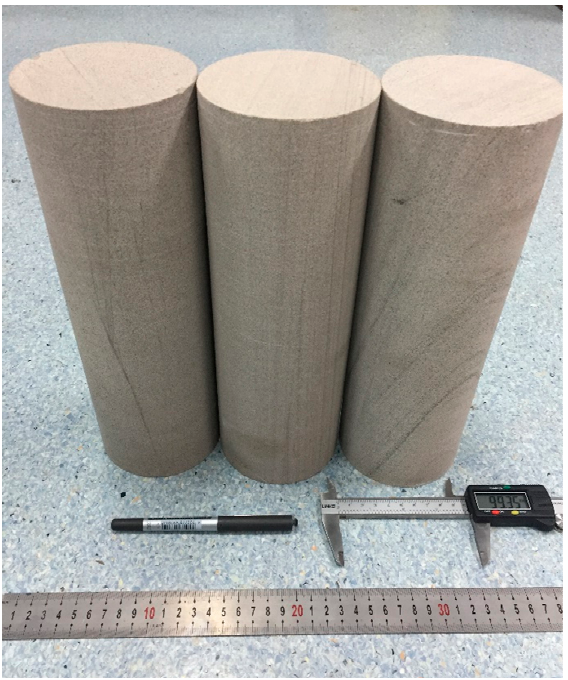
Figure 1 . Core samples used in the experiment. Figure 1. Core samples used in the